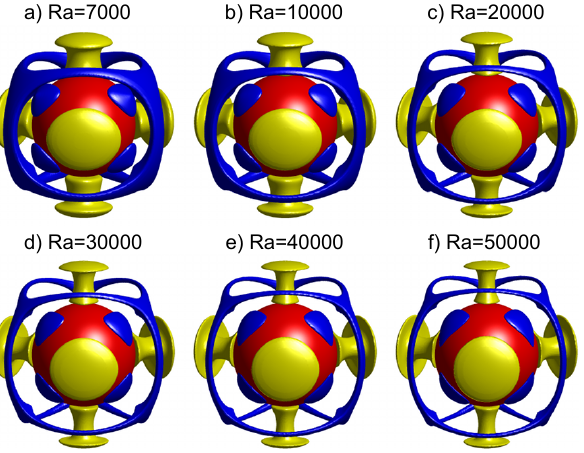
Figure 13. Stability of steady-state five-cell convection pattern as a function of the Rayleigh, displayed by the residual temperature for γ = 0 . 5 (a) Ra = 7 × 10 3 , (b) 10 4 , (c) 2 × 10 4 , (d) 3 × 10 4 , (e) 4 × 10 4 and (f) 5 × 10 4